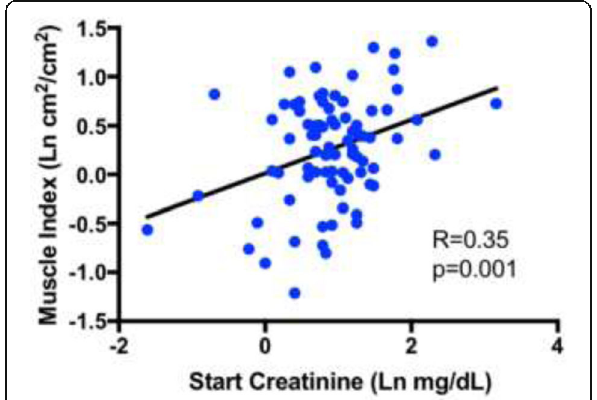
Fig. 1 (abstract 0066). Correlation Between Creatinine and Muscle Mass